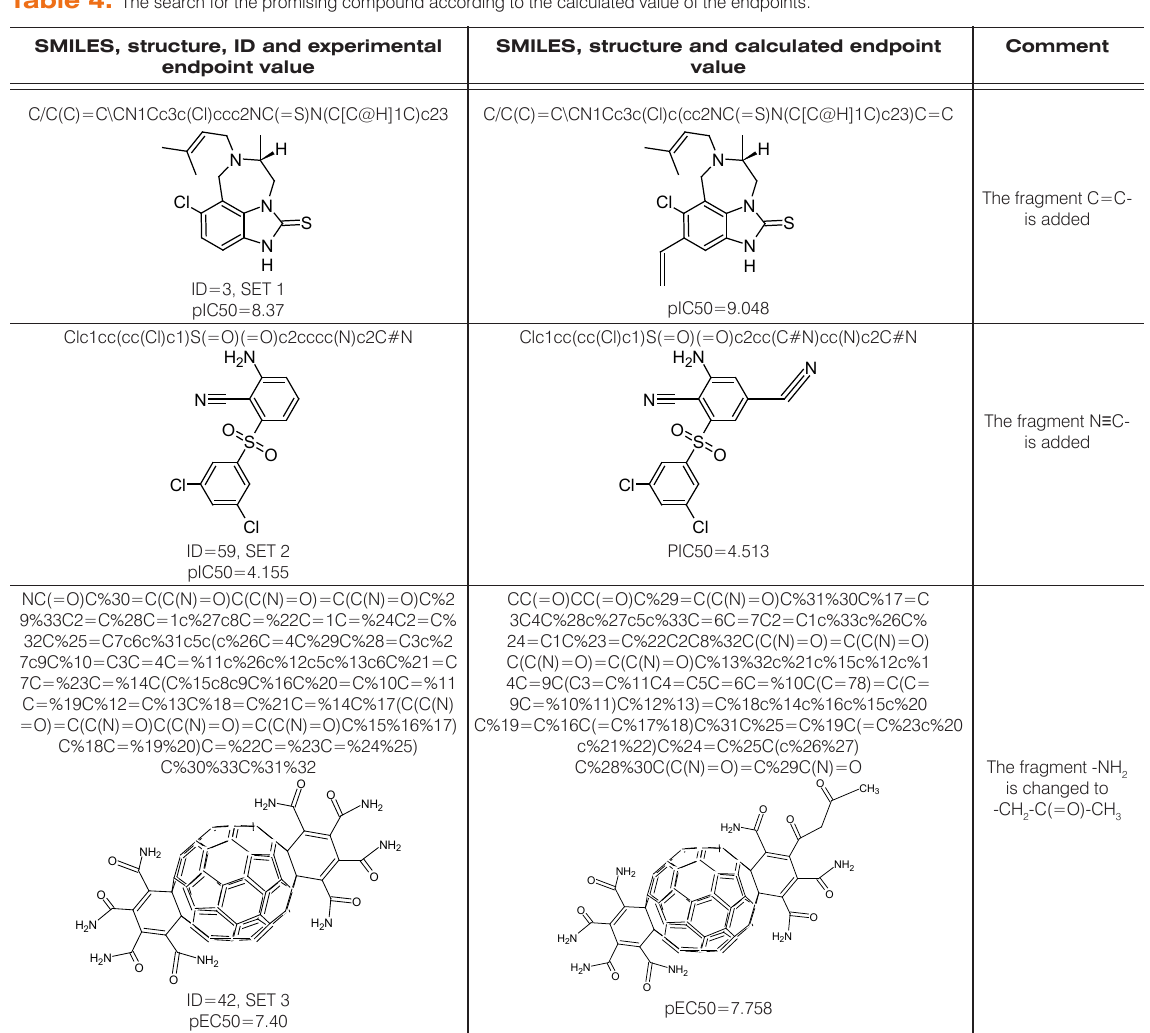
SMILES, structure and calculated endpoint Comment value